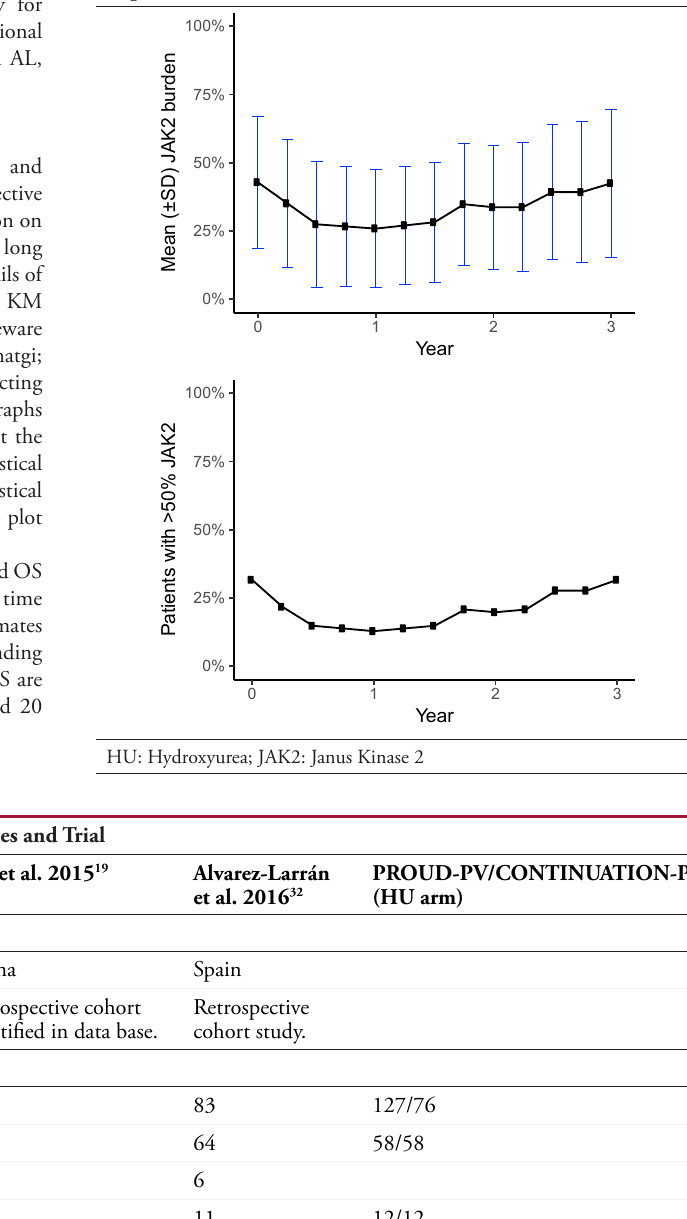
Figure 2. Mean JAK2 burden (HU arm) and modelled proportion of patients with JAK2 burden >50%